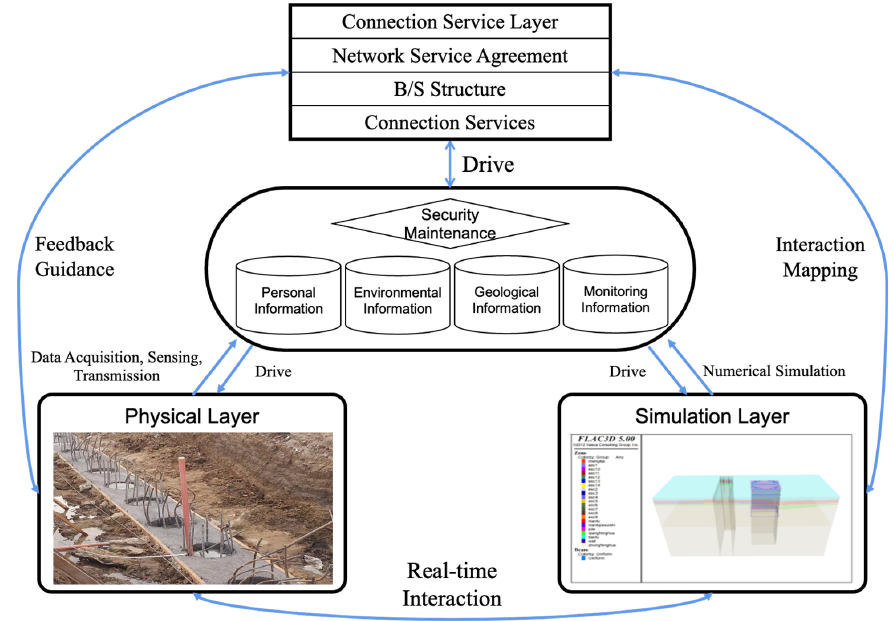
Figure 2. An overall framework of foundation pit excavation based on digital twin.